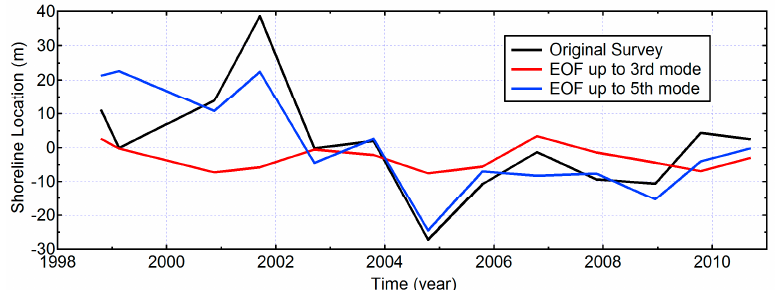
Figure 19. Comparison of shoreline variation within the original survey record, reconstructed variation by the superposition of empirical orthogonal function (EOF) results up to the third ( Z 1 ‐ 3 = C 1 e 1 + C 2 e 2 + C 3 e 3 ) and fifth ( Z 1 ‐ 5 = C 1 e 1 + … + C 5 e 5 ) modes.